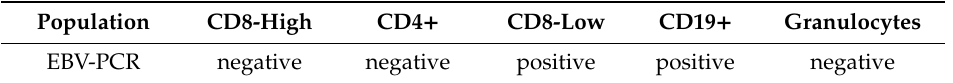
Table 3. EBV-PCR analysis of FACS-sorted cell